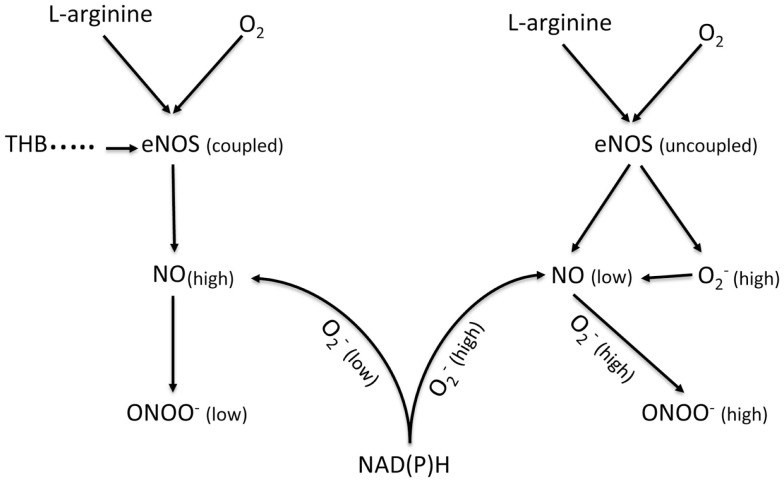
Schematic diagram showing the generation of NO and ONOO− from a coupled eNOS and an uncoupled eNOS in a normal and a dysfunctional endothelium, respectively. eNOS, endothelial nitric oxide synthase; NAD(P)H, nicotinamide adenine dinucleotide (phosphate); TDB, tetrahydrobiopterin.